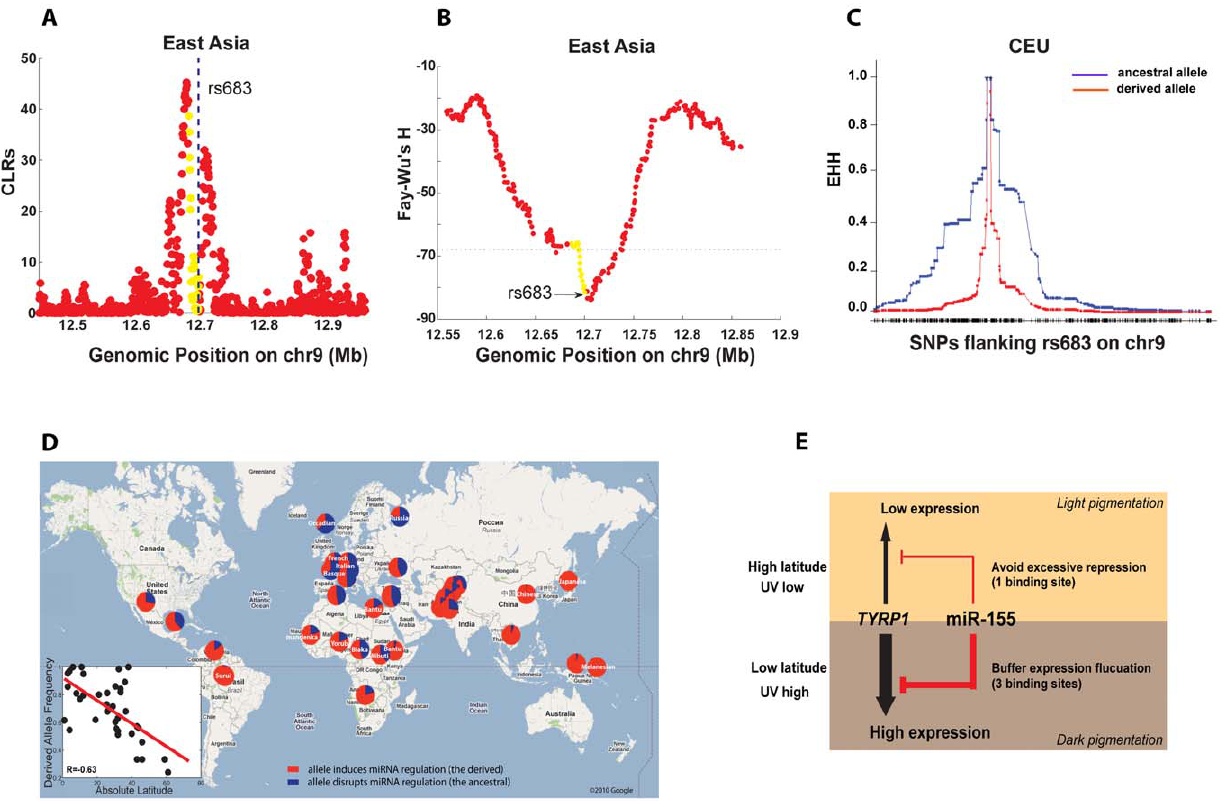
Figure 4. Population analysis of the miR-155 binding sites on TYRP1 . (A–B) Statistical tests for positive selection that fixed the derived allele of rs683 in East Asians. The yellow dots represent genic position on TYRP1 , and the flanking non-genic positions are in red. The CLR test (A, where the dotted line indicates the rs683 locus) and Fay-Wu’s H test (B, where the dotted line indicates the 5% extreme value among the genome-wide SNPs) were used. (C) Recent expansion by positive selection for the ancestral allele of rs683 in CEU. The expanded haplotype homozygosity (EHH) for both the ancestral allele (in blue) and the derived allele (in red) are shown. (D) The frequencies of the derived allele of rs683 across world populations. The derived allele induces miR-155 regulation on TYRP1 . The allele frequencies represented by the pie charts are overlaid on a customized Google Map. The inset indicates a significant negative correlation between the frequencies of the derived allele (which induces miR-155 regulation) in populations and the latitudes of population residence. (E) The model accounting for positive selection on alternate alleles of rs683 and rs910 to induce or disrupt miRNA regulation on TYRP1 in different human populations. TYRP1 shows higher expression in low latitudes than in high latitudes; thus selection for the derived alleles is to fix additional miRNA regulation on the highly expressed TYRP1 , which buffers expression fluctuation. As TYRP1 has low expression in high latitudes, then selection for the ancestral allele to disrupt miRNA regulation is a protective mechanism against excessive repression on TYRP1